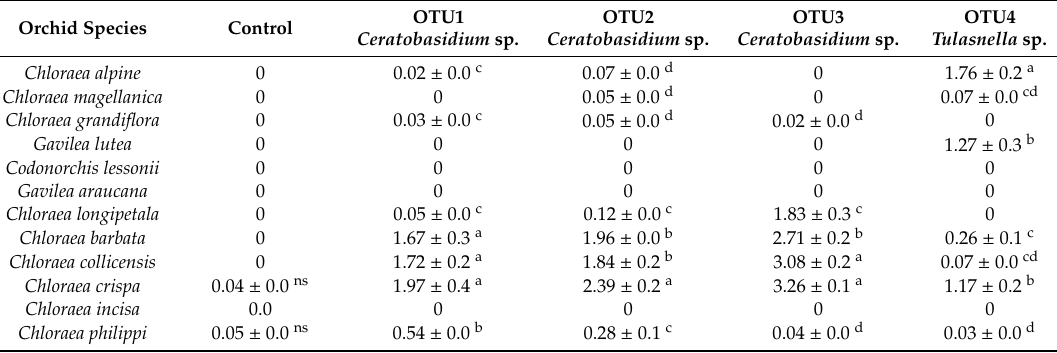
Table 4. Symbiotic germination index (GI) for the four tested isolated fungal strains on twelve orchid seeds over 60 days of in vitro culture. Results are means ± standard deviation for n = 5. Di ff errent letters in the GI of each OTU are significantly di ff erent according to Tukey’s multiple range test ( p <